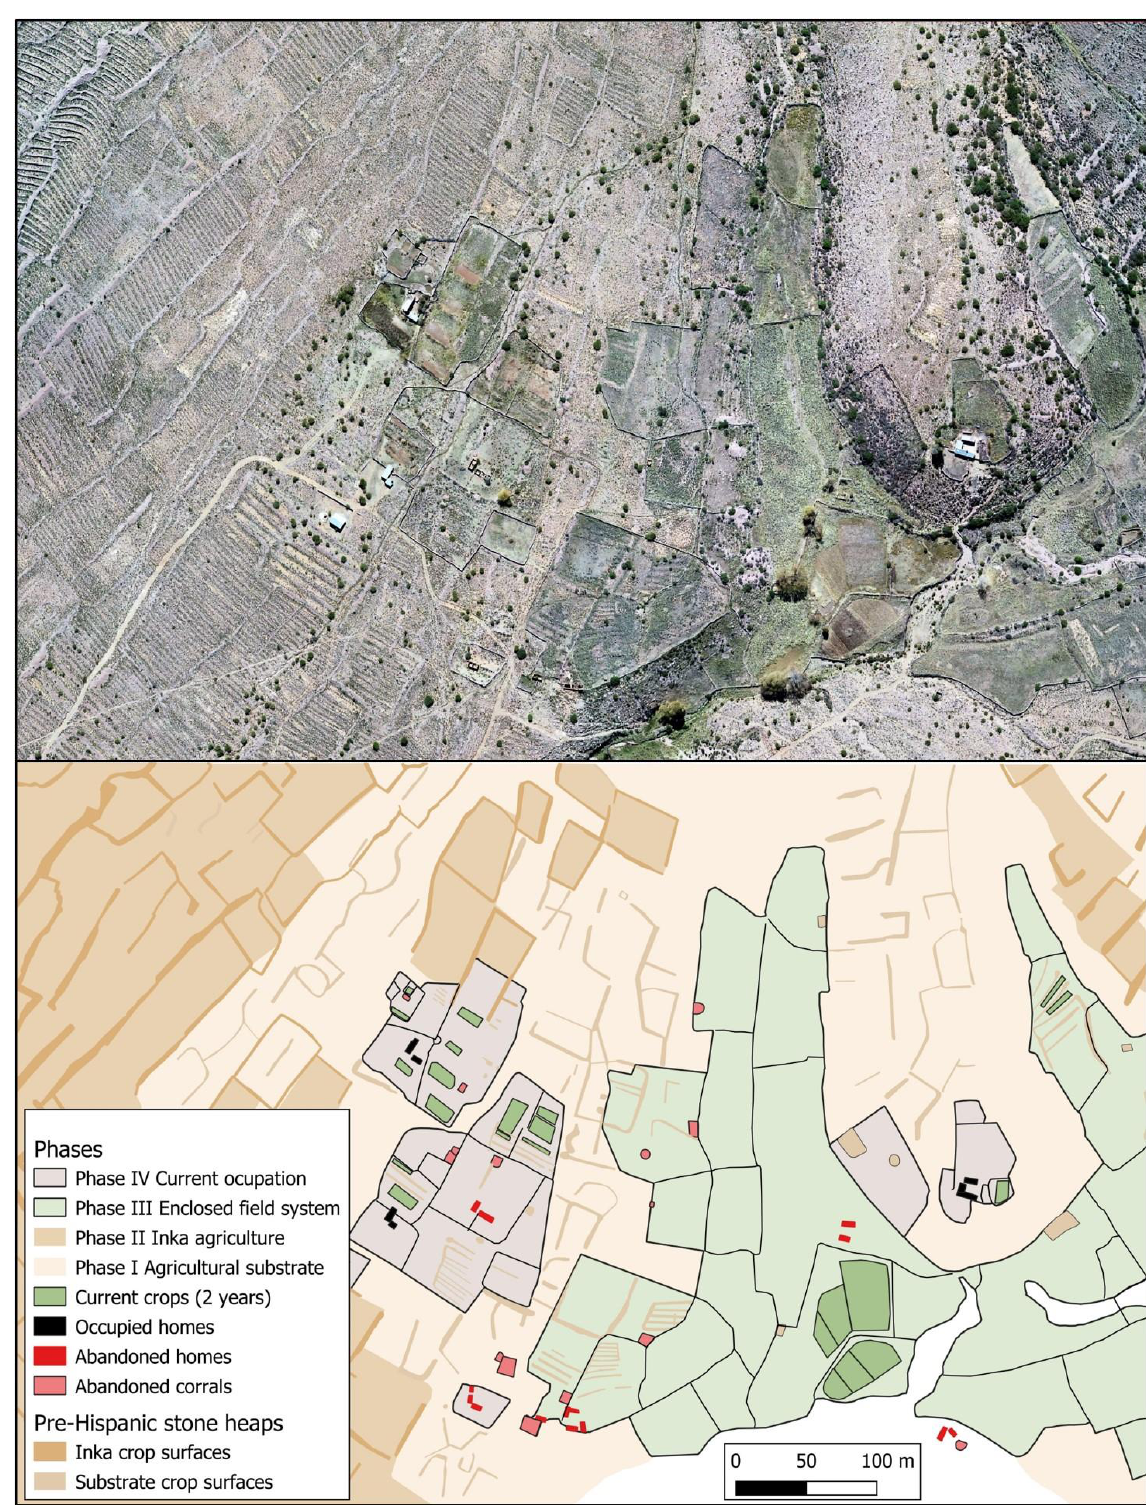
Figure 11. Example of multi-temporal sector in the locality of Coctaca (photo: Pablo Cruz, CONICET, 2019).